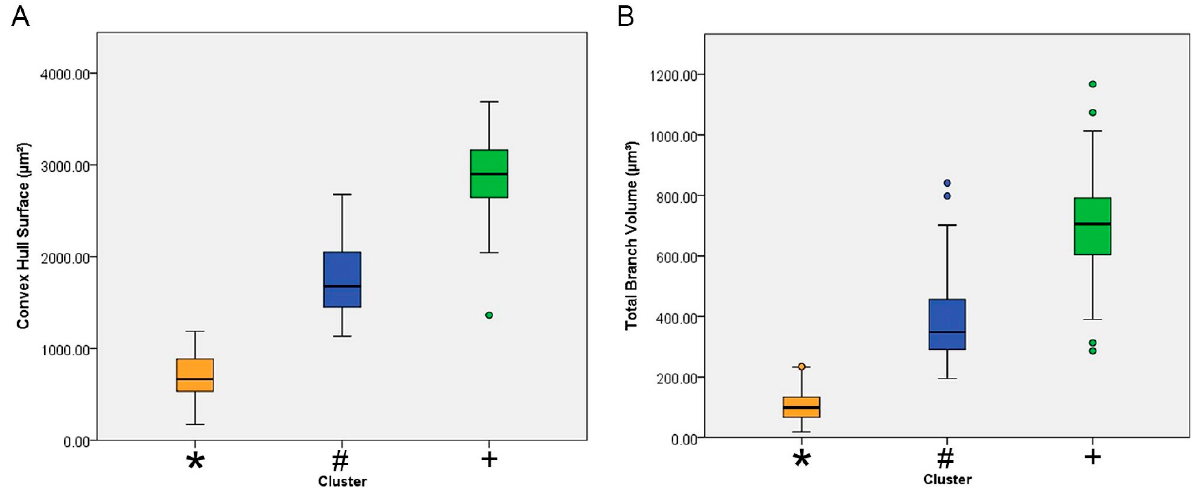
Figure 3. Mean values and corresponding standard errors (box edges) and standard deviations (whiskers) for the surface of the convex hull ( A ) and total branch volume ( B ) for microglia of Figure 1. Infected animals correspond to clusters 1(blue/#) and 2 (green/+) and control animals to cluster 3 (orange/*). Note that when compared to the microglia of the control animals, the mean value of the convex hull surface area of the microglia of the infected animals was 3 to 6-fold greater.